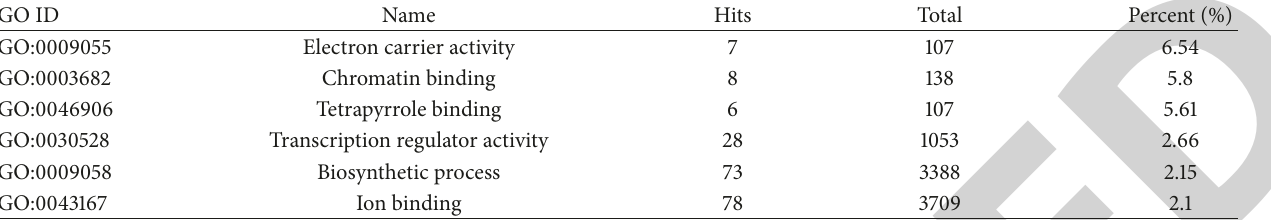
Table 4: GO of statistical significance.